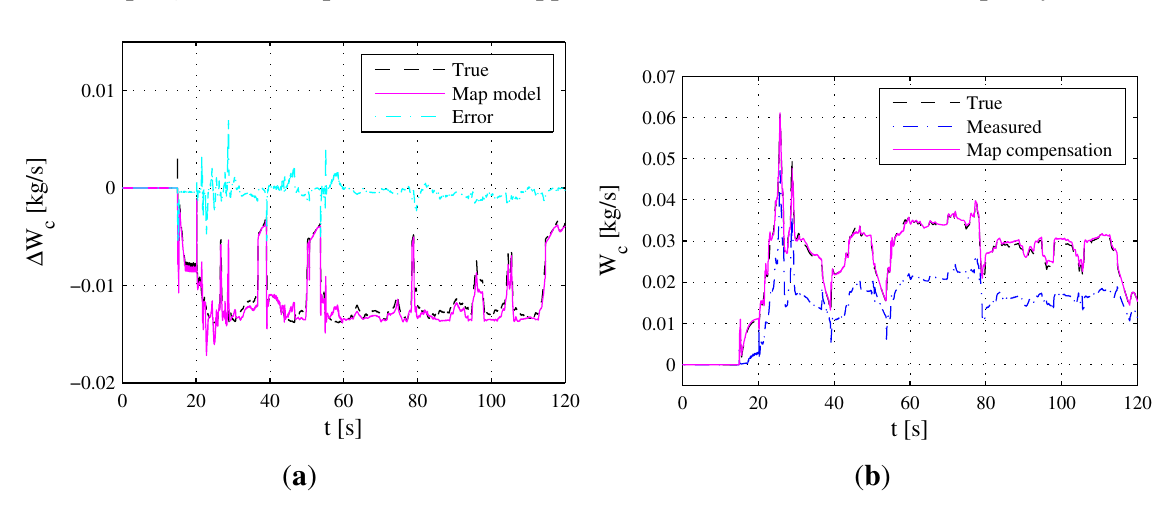
Figure 9. 2D map compensation during the FTP75 segment. ( a ) Simulation results between ( u , n ) and the estimated 2D map; ( b ) Simulation results of true reference error ∆ W c δ e